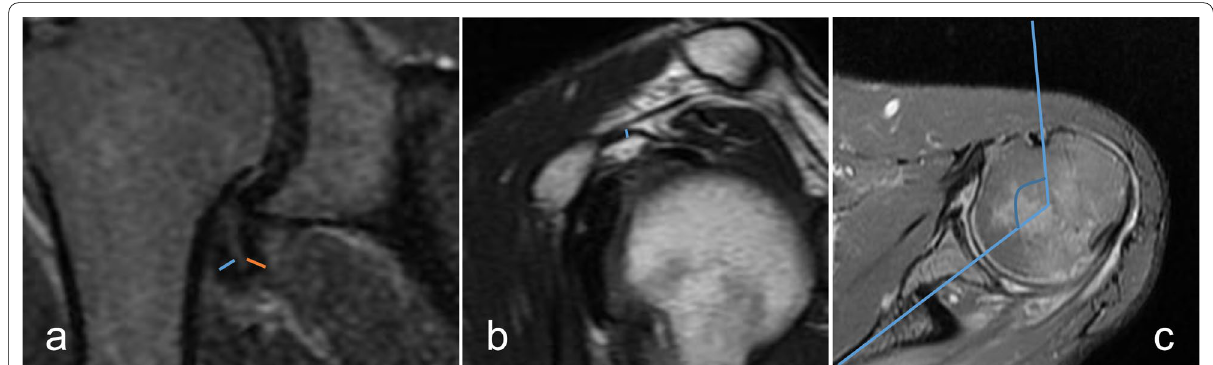
Fig. 3 Example illustrating quantitative measurements in MRI findings. a A 56-year-old woman with clinical diagnosis of adhesive capsulitis (shoulder pain and limitation of movement). Oblique coronal fat-sat T2-weighted image demonstrating measurement of the thickest part of axillary shoulder joint capsule in both humeral (blue line) and glenoid (red line)aspects. b A 59-year-old man among the control group cases. Oblique sagittal T2-weighted image demonstrating the thickness of the coracohumeral ligament (blue line). c A 56-year-old man among the control group cases. Axial fat-sat PD MR image noted at the level of the humeral head center illustrating the extent of shoulder external rotation. The extent of shoulder external rotation was measured in the form of an angle noted between two lines, one line extending between the center of humeral head and the longitudinal axis of scapula, and another line drawn between the center of the humeral head and the bicipital